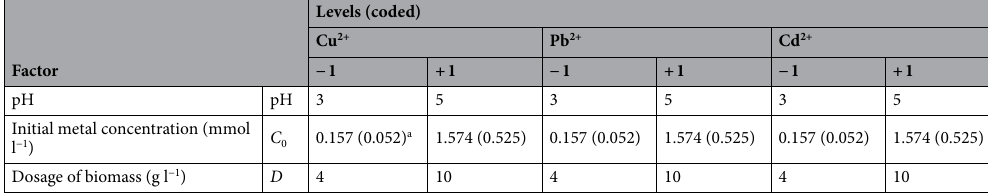
Table 1. Factors and levels used in 23 factorial design for single and ternary biosorption experiments. a Numbers in parenthesis represent initial metal concentration (mmol l −1 ) for ternary experiment.